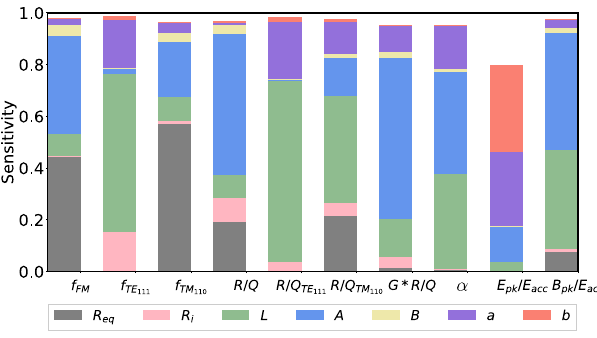
FIG. 5. Main sensitivities. The intervals for the geometric parameters R eq ; R i ; L; A; B; a; b are given in Table II. The polynomial degree is p ¼ 2 , so the size of the sample is 216 [cf. Table I].